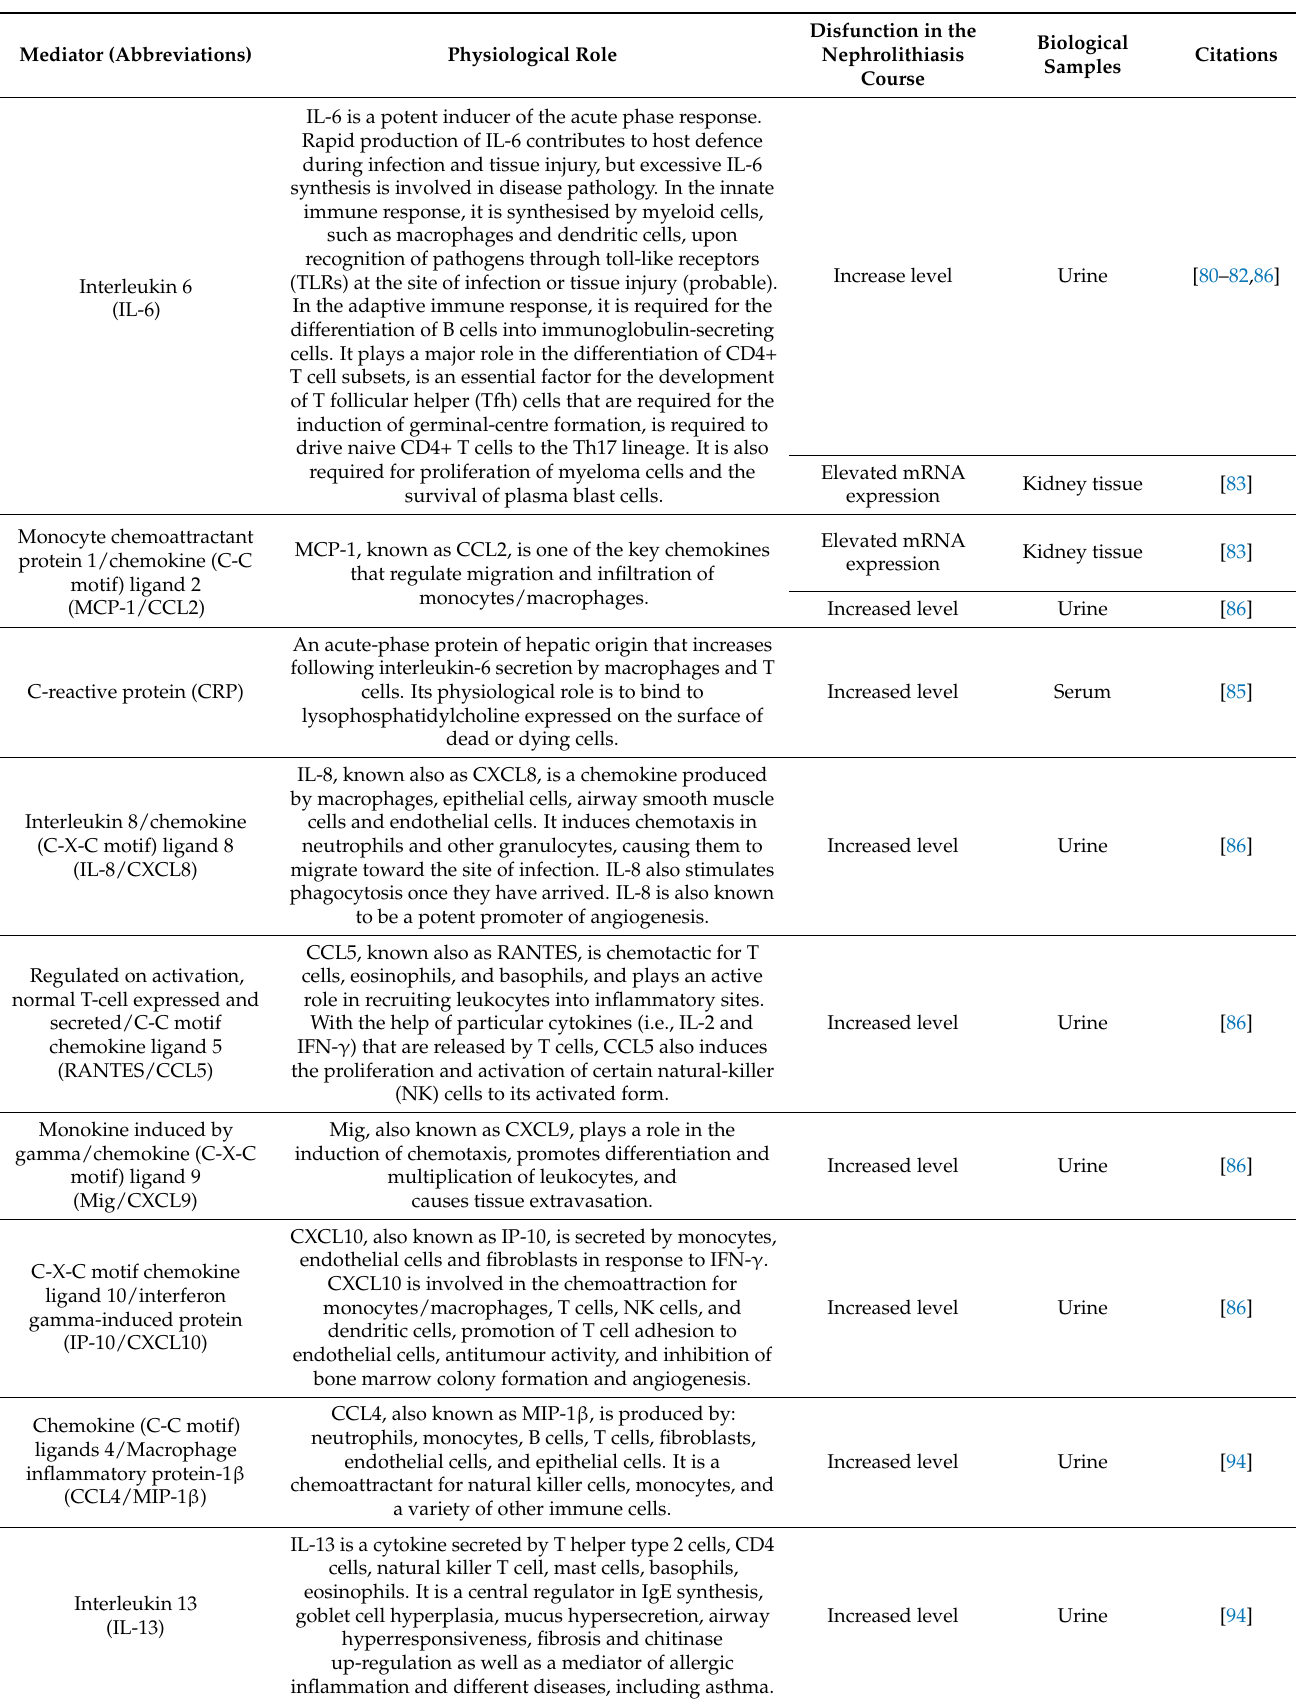
Table 2. Potential biomarkers associated with inflammation in kidney stone